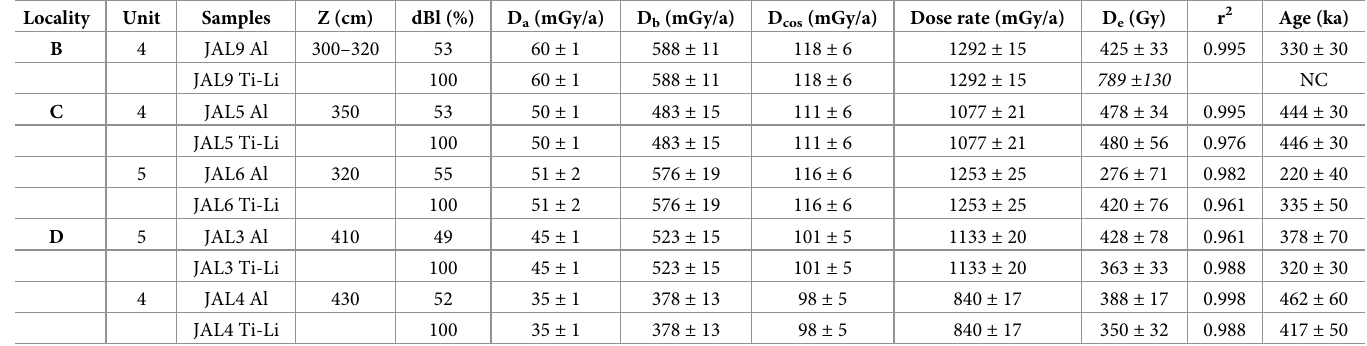
Table 6. ESR age estimation